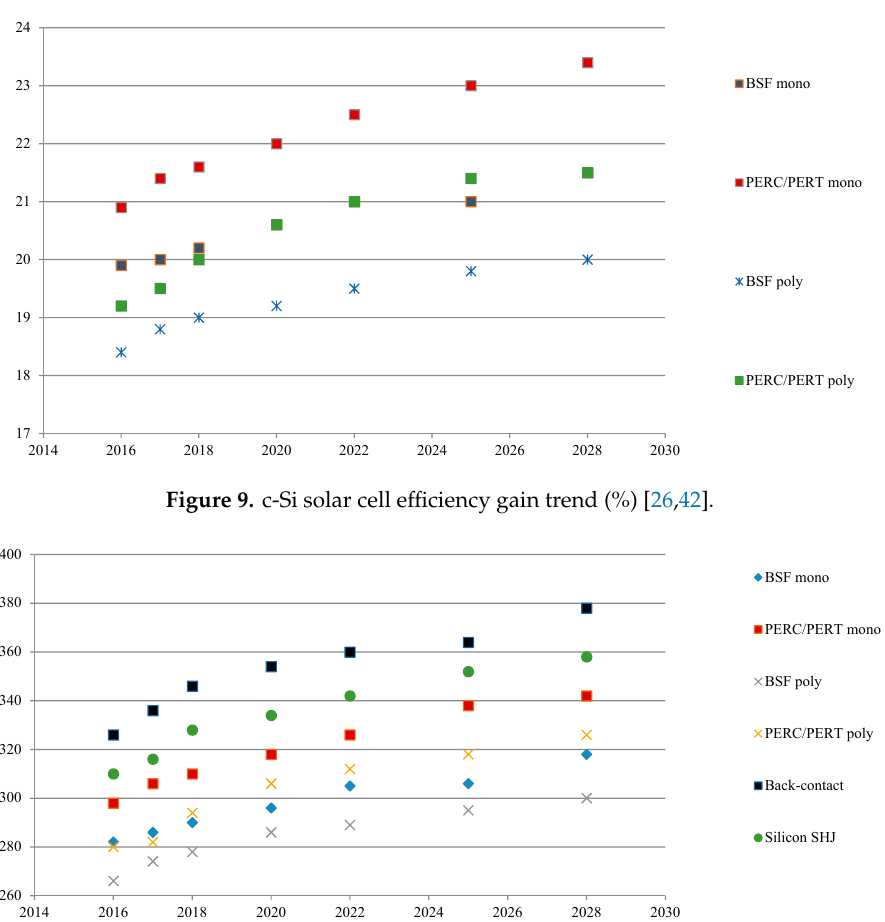
Figure 10. c-Si module power gain trend (Wp) [26,42].